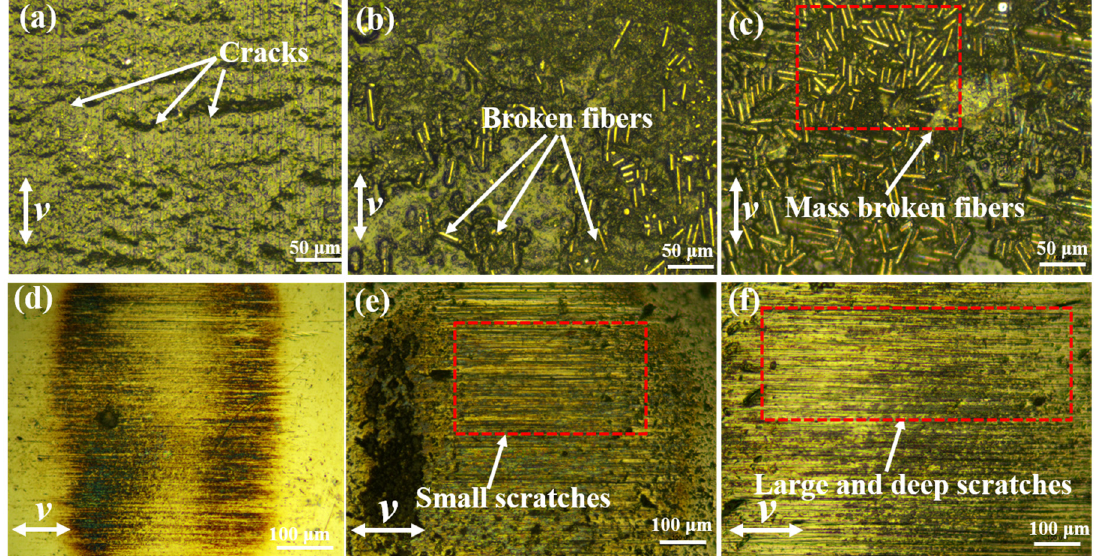
Figure 11. Optical images of worn surface of FGr@MoS 2 -1.2 at ( a ) 23 °C, ( b ) 40 °C, and ( c ) 60 °C; counterpart ball at ( d ) 23 °C, ( e ) 40 °C, and ( f ) 60 °C.